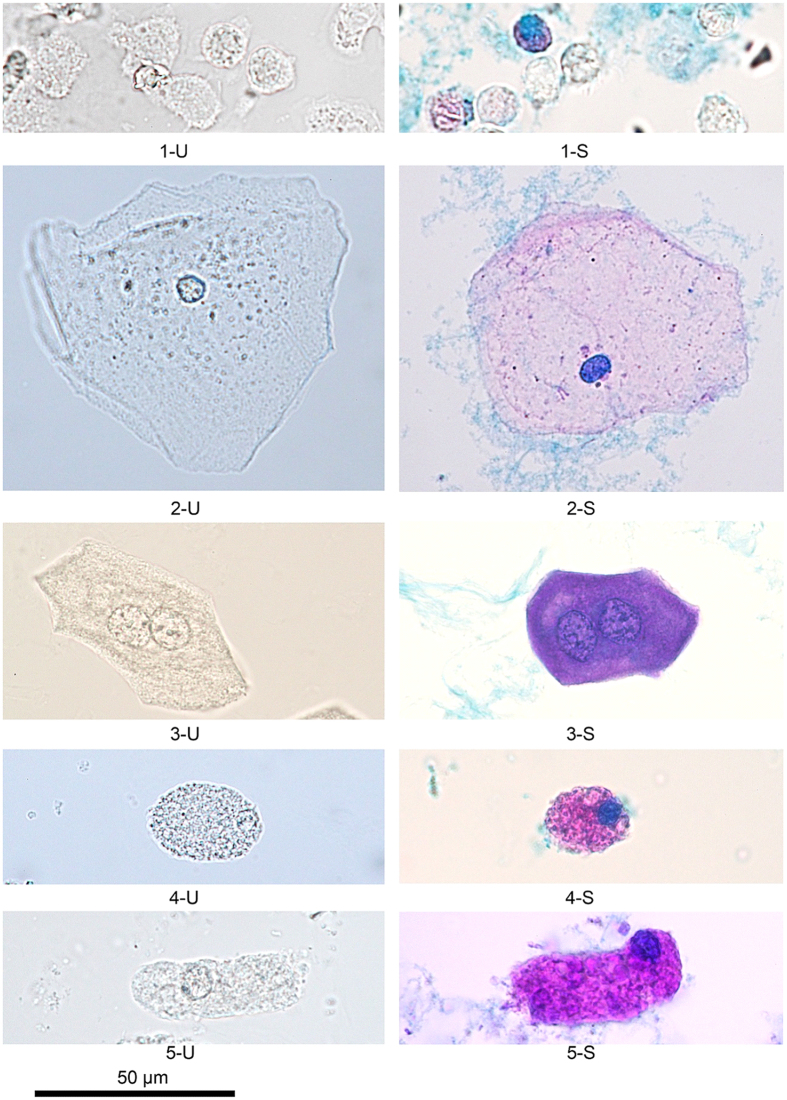
Various cells, 400×.U, unstained; S, Sternheimer stain. (1-U) Active neutrophils vary in shape from amoeboid to round. (1-S) After staining, active neutrophils are round. The cytoplasm and nucleus are colourless. When the cells are damaged, the cytoplasm will be pale pink, and the nucleus will be dense blue. (2-U) Squamous epithelial cell: the size of its nucleus is about that of a red blood cell. The cellular margin is polygonal, and the cytoplasmic clarity is high, with a homogenous surface. (2-S) After staining, the cytoplasm is pale pink, and the nucleus is dense blue. (3-U) Urothelial cell: the nucleus is 1.5 times that of a white blood cell, and the nucleolus is prominent. The cytoplasmic clarity is low. The cellular margin is distinctly shaped, curved, and polygonal. (3-S) After staining, the cytoplasm is dense purple, and the nucleus is purple-blue. (4-U and 5-U) Renal tubular epithelial cell: The nucleus is shrunken and eccentric, and the cytoplasm is sandy with granules. The cellular margin is uneven. (4-S and 5-S) After staining, the cytoplasm is pink-red, and the nucleus is cyan blue and very eccentric.